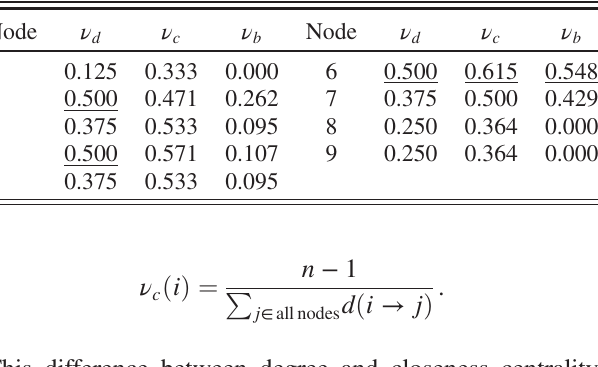
TABLE II. Four measures of centrality, ( ν d , ν c , and ν b ), are listed for the graph in Fig. 2. Highest values are underlined.